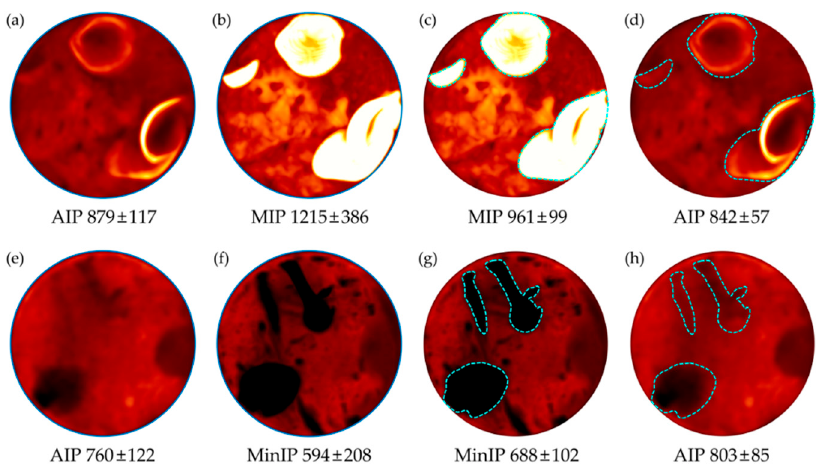
Figure 2. CT-scan images of a 20-mm-thick slab of sediment cores GO20 ( a – d ) and SC17 ( e – h ); the CT number ± standard deviation (STD) in HU units is shown below each image. ( a ) Average Inten- sity Projection (AIP) algorithm and ( b ) Maximum Intensity Projection (MIP) algorithm of the whole axial slice; ( c ) MIP algorithm with high-density regions of interests (ROI—white areas, contoured) removed; ( d ) AIP algorithm with high-density ROI removed from CT number calculation; ( e ) AIP algorithm and ( f ) Minimum Intensity Projection (MinIP) algorithm of the whole axial slice; ( g ) MinIP algorithm with low-density ROI (dark areas, contoured); ( h ) AIP algorithm with low-density ROI removed from CT number calculation.